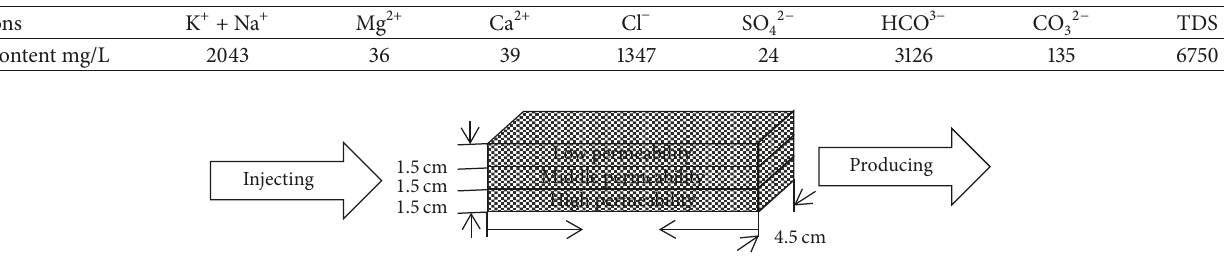
Table 1: Composition of injected water.